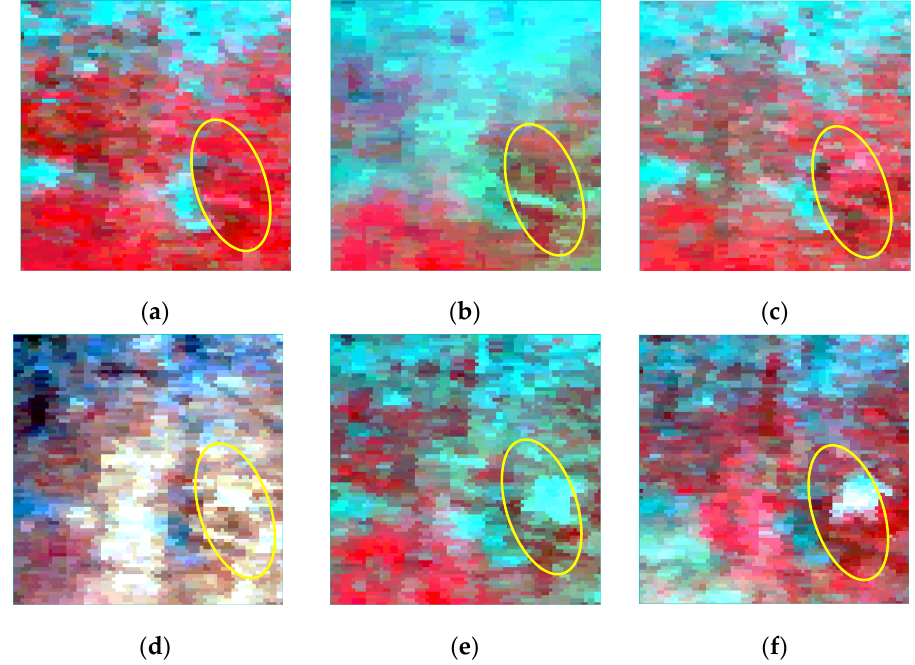
Figure 11. MODIS images from the Daxing dataset reflecting land cover changes. Dates: ( a ) 1 Sep-